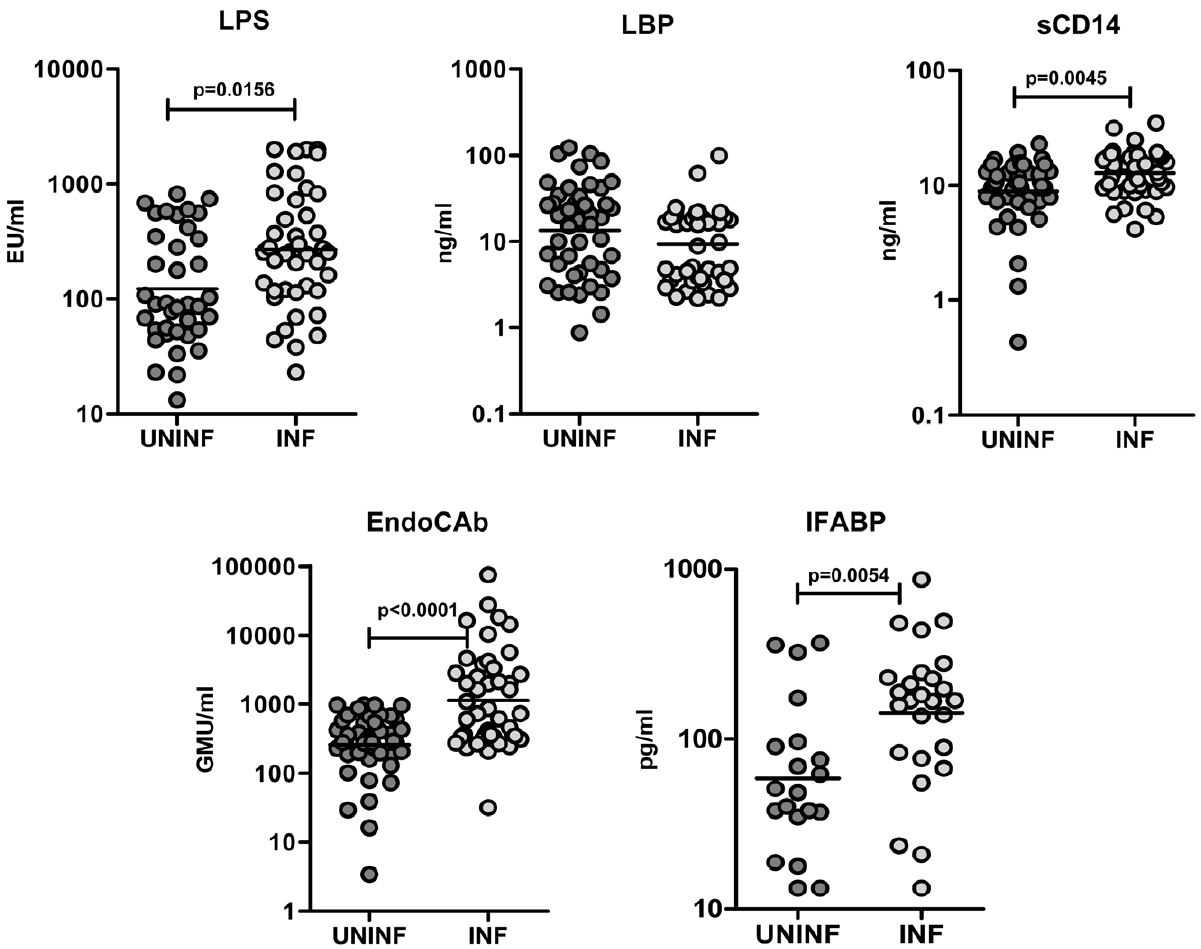
Figure 1. Hookworm infection is associated with elevated levels of LPS, sCD14, EndoCAb, and IFABP. Plasma levels of lipopolysaccharide (LPS), lipid binding protein (LBP), soluble CD14 (sCD14), endotoxin core antibody IgG (EndoCAb), and intestinal fatty acid binding protein(FABP) from hookworm-infected [INF] (n=27–46) or uninfected [UNINF] (n=20–45) individuals were measured by ELISA. P values were calculated using the Mann-Whitney